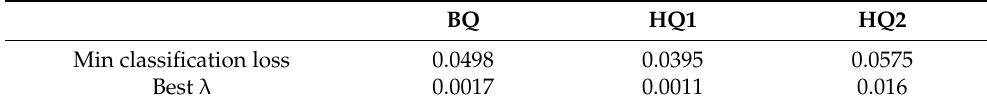
Table 3. Final best λ values for neighborhood component analysis and the related minimum classification loss. BQ HQ1